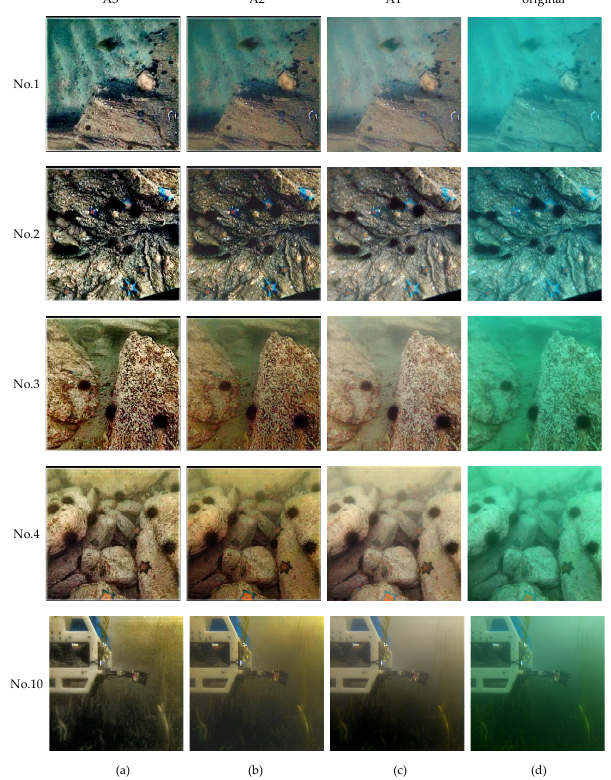
Figure 9. Ablation experiments. ( a ) images processed by GAN, the all-in-one model-based CNN, and adaptive contrast enhancement; ( b ) images processed by GAN and the all-in-one model-based CNN; ( c ) images processed by GAN; ( d ) original images. 5.3. Quantitative Evaluation Due to the discrepancy of individual perception, the visual effect of a processed im- age might be different for a different person. Therefore, quantitative evaluation metrics